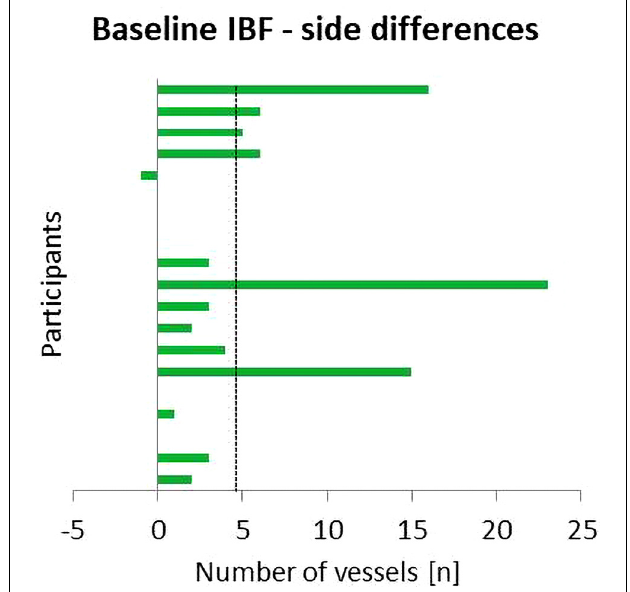
FIGURE 3 | Side differences between IBF at baseline (Upre) in the symptomatic and asymptomatic Achilles tendon (AT). Positive values indicate higher amount of IBF in the symptomatic AT; dashed line indicates mean difference.